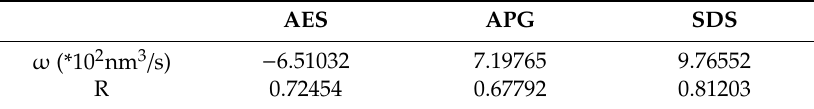
Table 2. Ostwald Ripening Rate ( ω ) of the